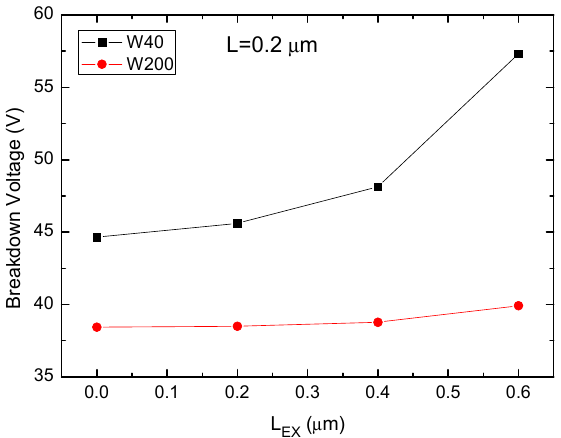
Figure 2. Breakdown voltage of FinTFTs with various L EX .